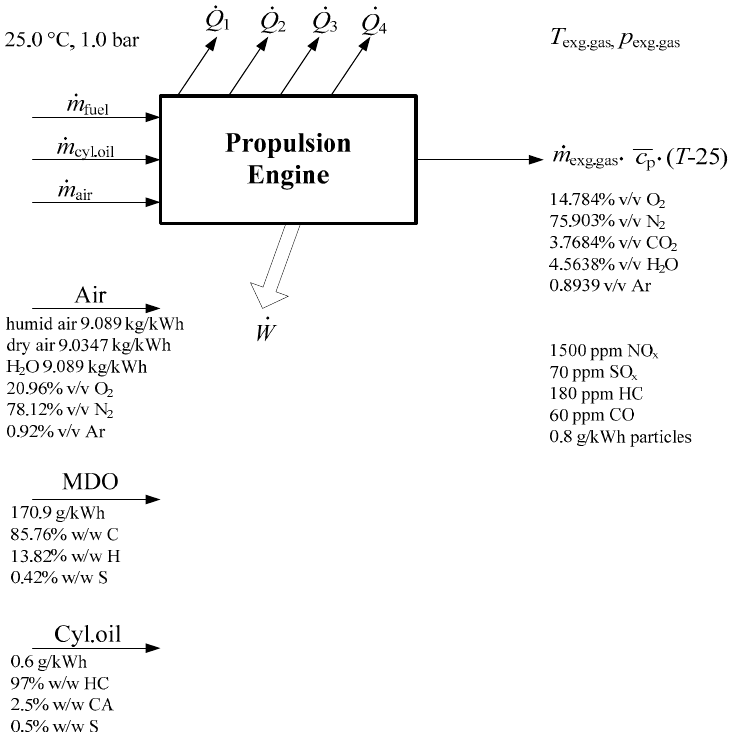
Figure 8. The calculated substance flow through the two-stroke low speed engine at 100% SMCR.